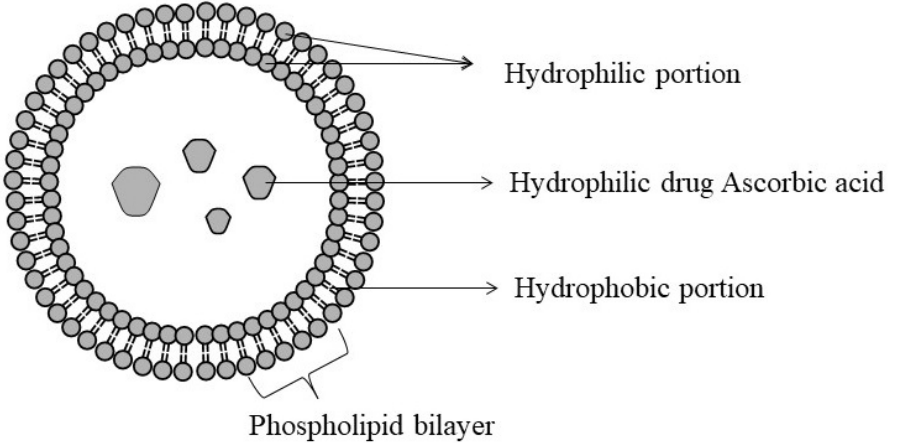
Figure 12. Structure of liposome.